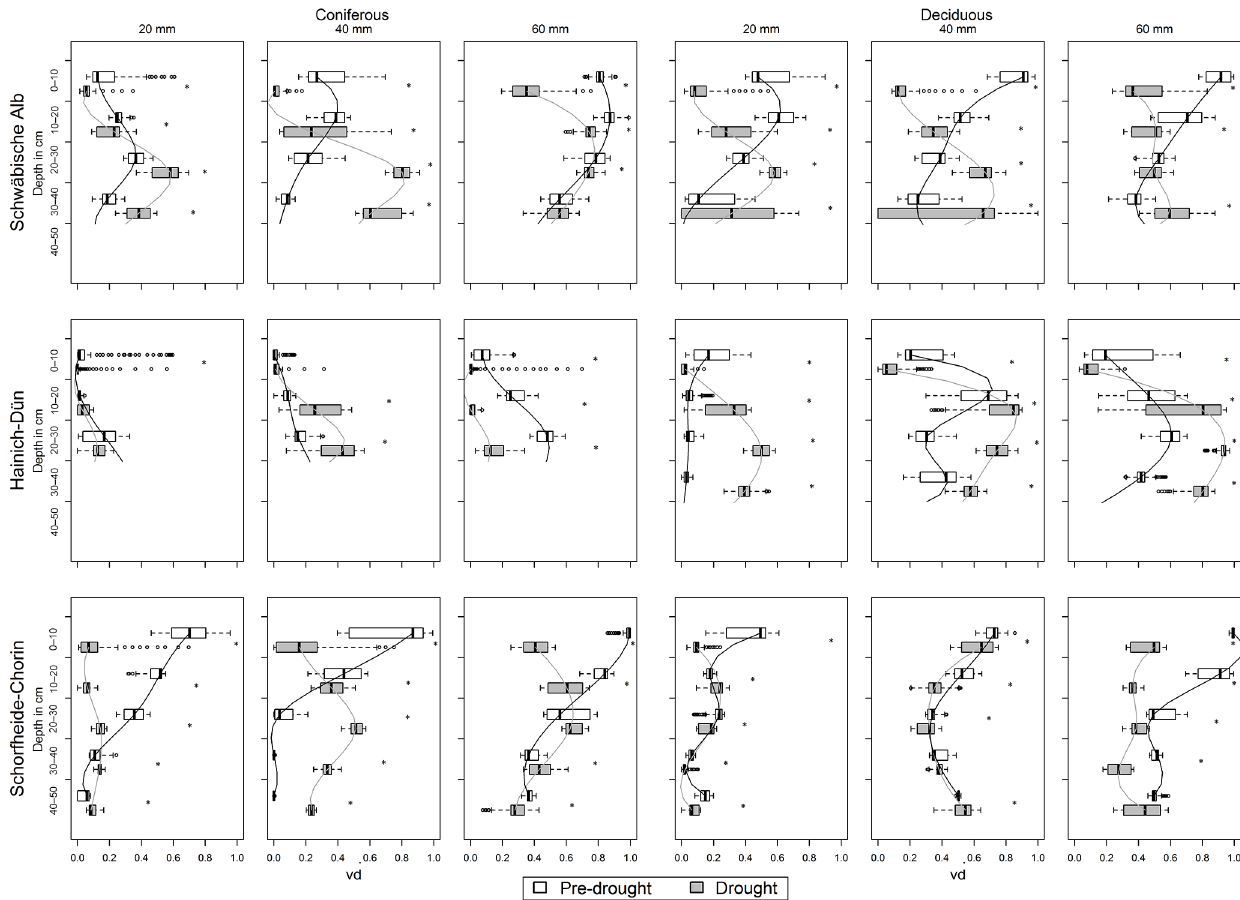
Figure 9. VD box plots of the drought and the pre-drought pattern. Depth ranges are omitted, where one of the profile is shorter than the other. Statistically significant ( p value ≤ 0.01) differences between the treatments are marked with an asterisk.